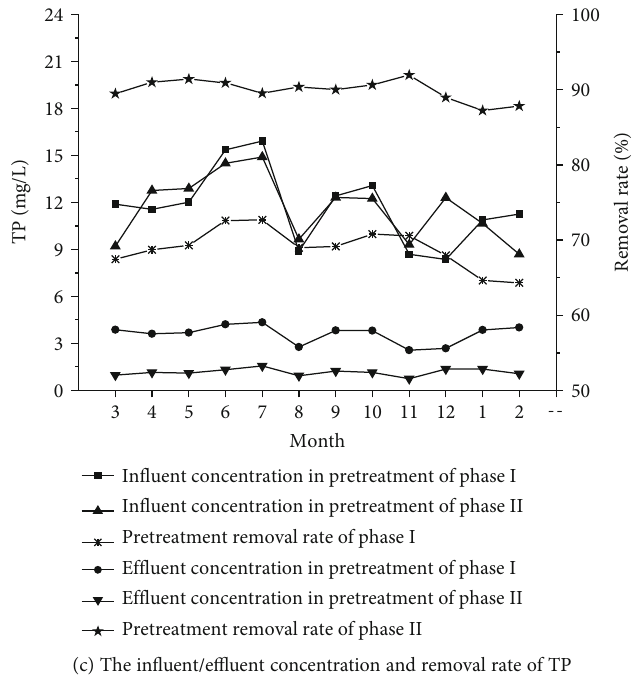
Figure 4: Di ff erent pretreatment inlet and outlet water concentrations and removal